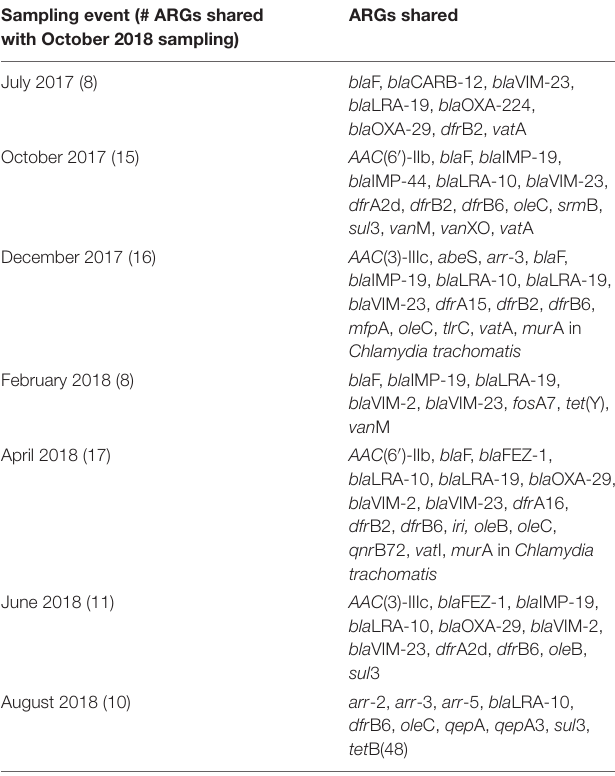
TABLE 3 | ARGs detected in the influent only, effluent only, or shared between influent and effluent determined by metagenomics. Sampling event (total ARGs in